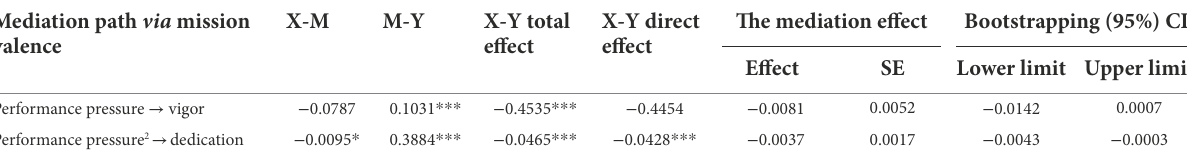
TABLE 7 Bootstrapped point estimate and confidence intervals (CI) of the mediating effects of mission valence on the indirect relationship between performance pressure and dedication/vigor. Mediation path via mission